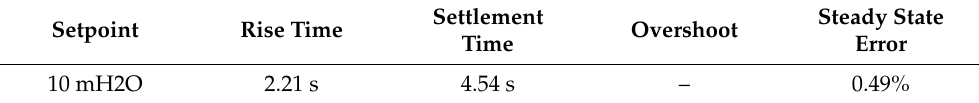
Figure 15. Response of fuzzy control with pumps operating in series. Table 5. Time characteristics of the response of fuzzy control with pumps operating in series.